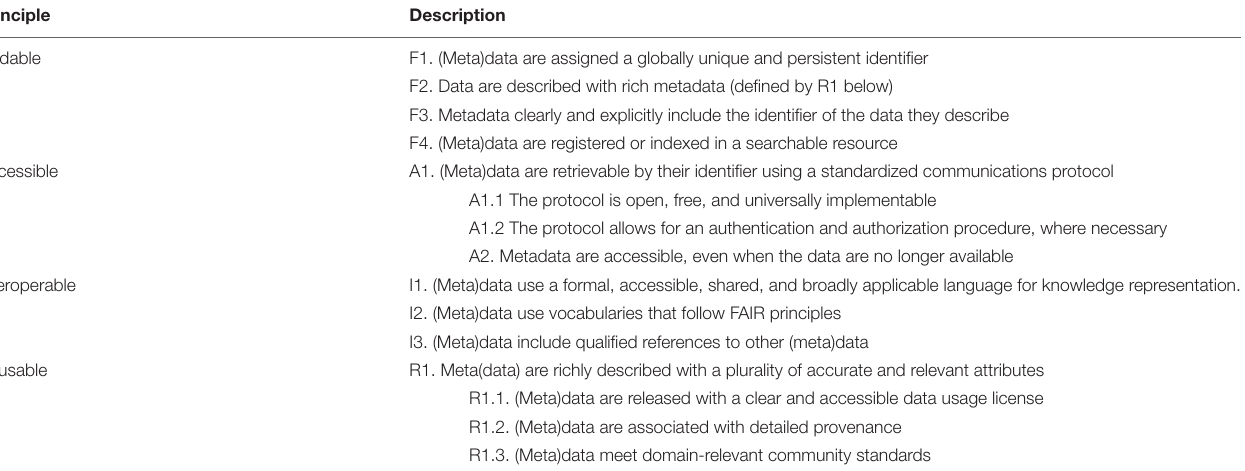
TABLE 1 | The FAIR principles for scientific data repository.